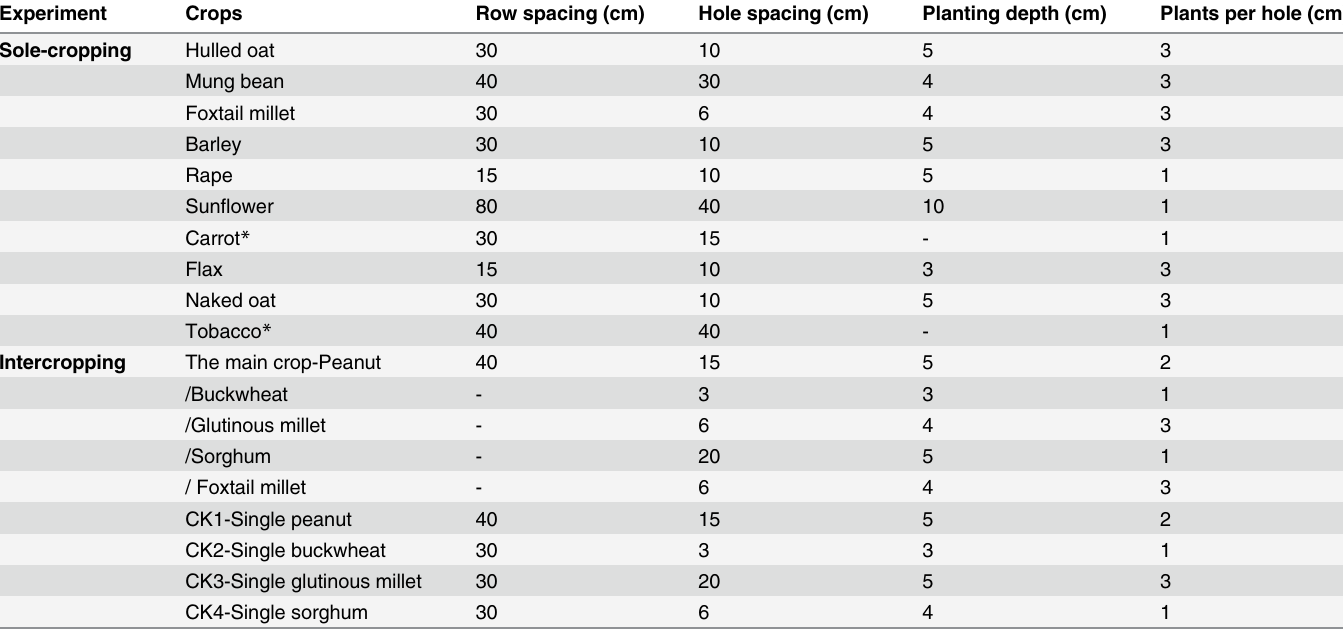
* Above the mentioned crops were directly sown to soil with the exception of tobacco and carrot seedlings, which were transplanted (row spacing and plant spacing) to the fi eld after establishment in seedling-beds for 25